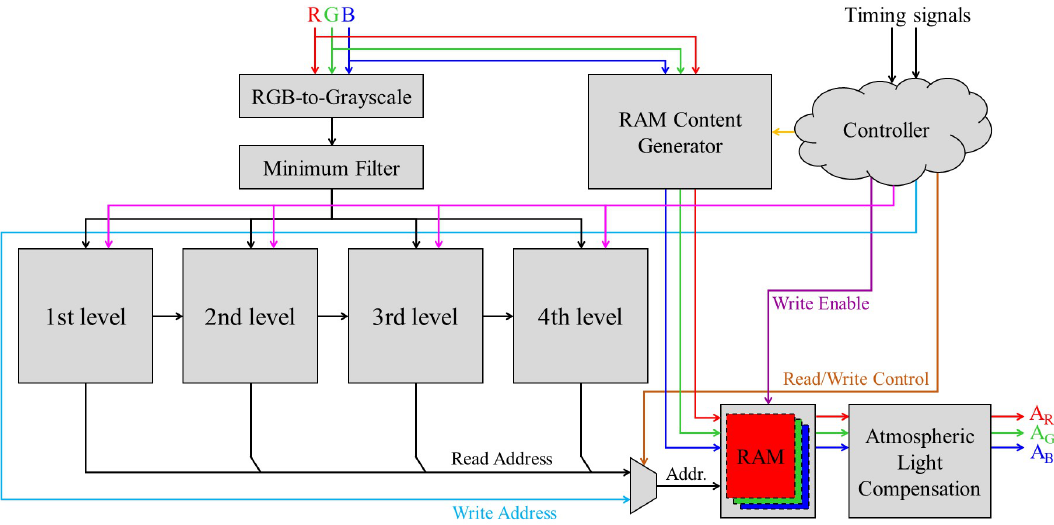
Figure 17. The proposed hardware architecture for atmospheric light estimation and